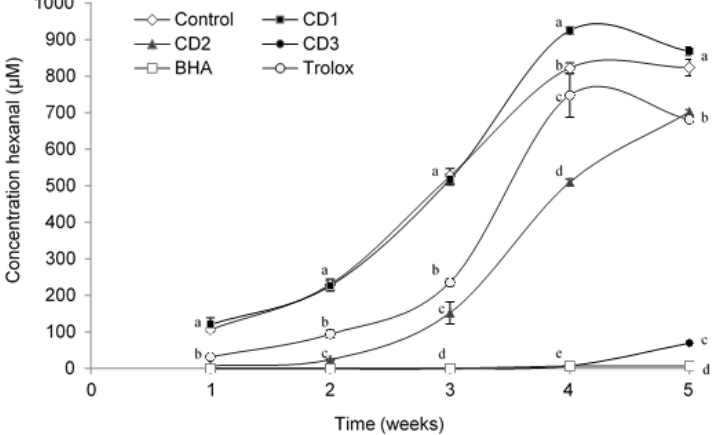
Figure 5. Change in the headspace hexanal concentration for oil-in-water emulsions during the study. Bars represent standard deviation ( n = 3). Different letters in the same day (a, b, c, d, e) indicate significant differences between samples.